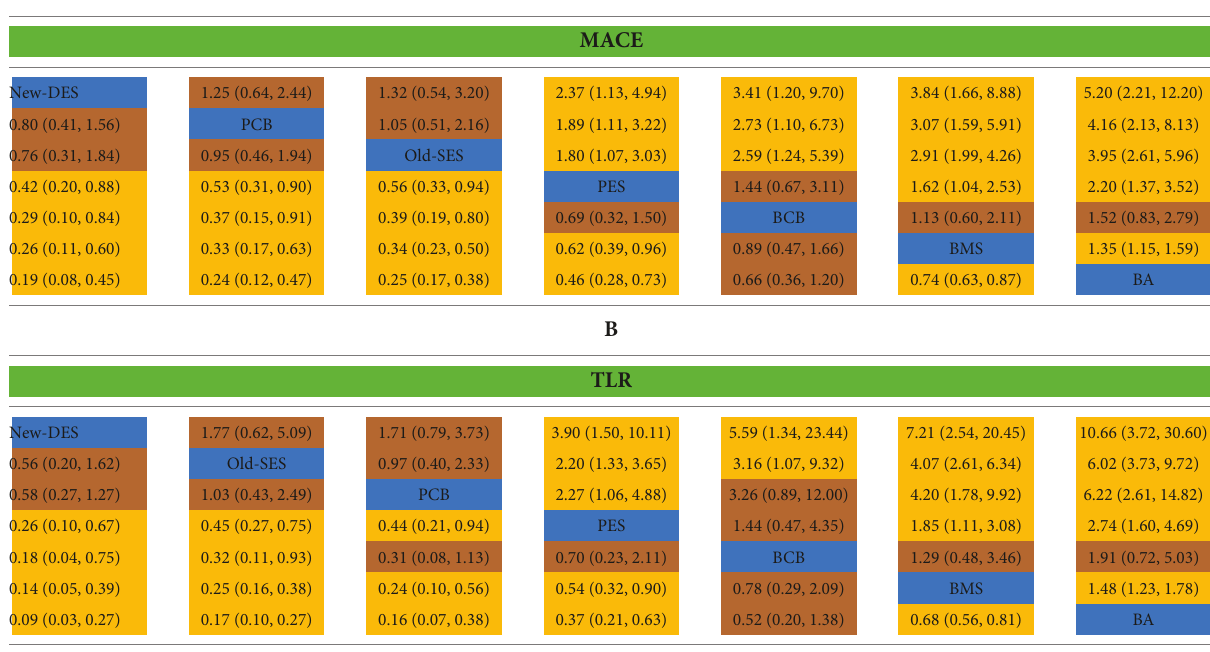
TABLE 3 The sensitivity network meta-analysis estimates of MACE and